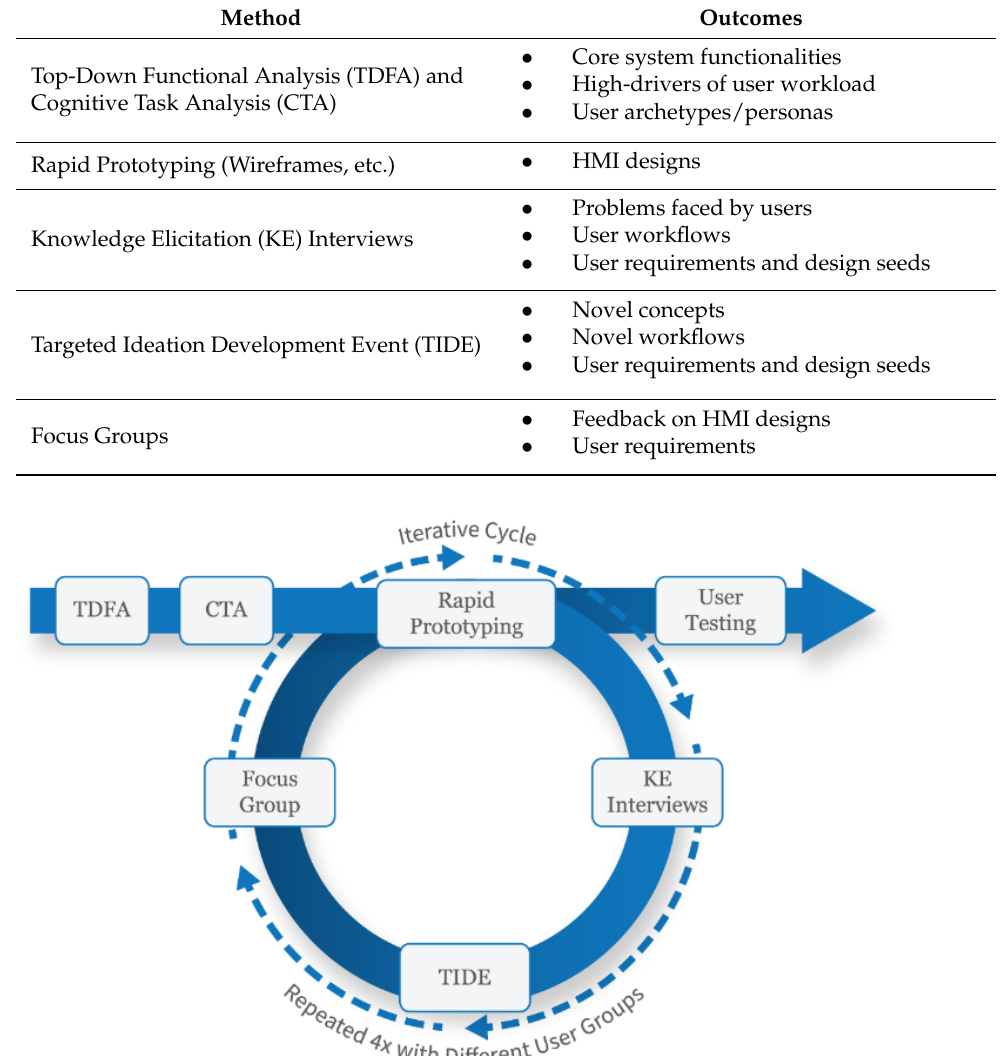
Table 1. Methods Employed in the UCD Framework.